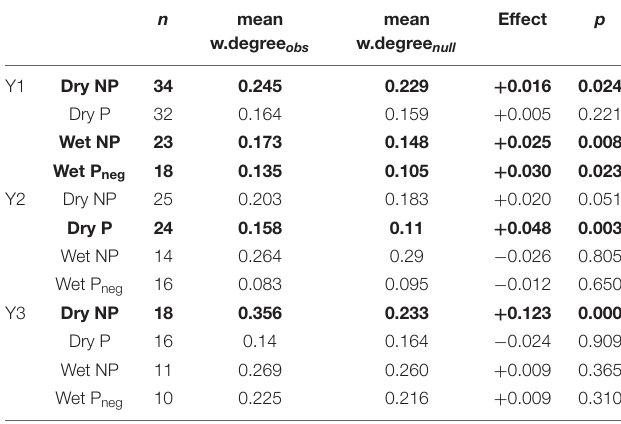
TABLE 2 | Testing for non-random social structure across season and provisioned (P)/non-provisioned (NP) sites monitored by acoustic receivers (note P neg indicates the wet season when provisioning was negligible).